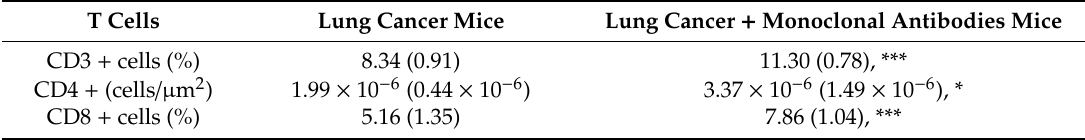
Table 3. Immune microenvironment in the study groups of